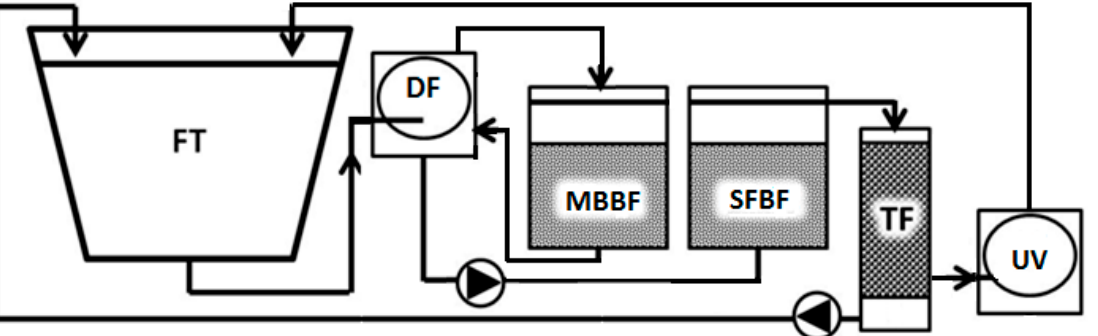
Figure 5. Flowchart of the RAS setup, showing a fish tank (FT), drum filter (DF), moving-bed biofilter (MBBF), sand-filled biofilter (SFBF), and a cascade aeration column (TF), followed by UV treatment.